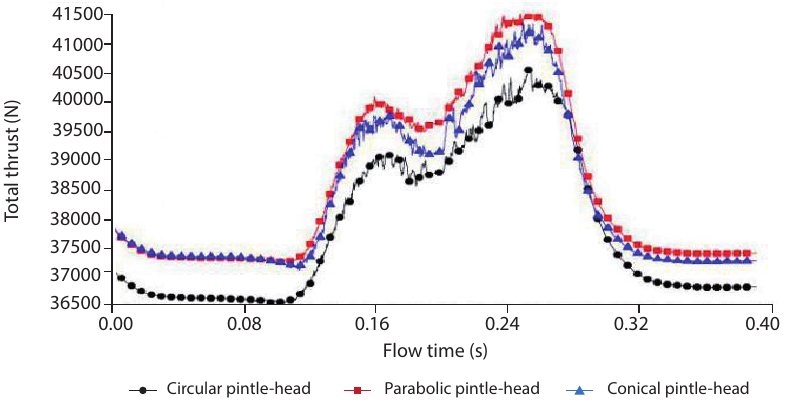
Figure 11. Total thrust of three different pintle